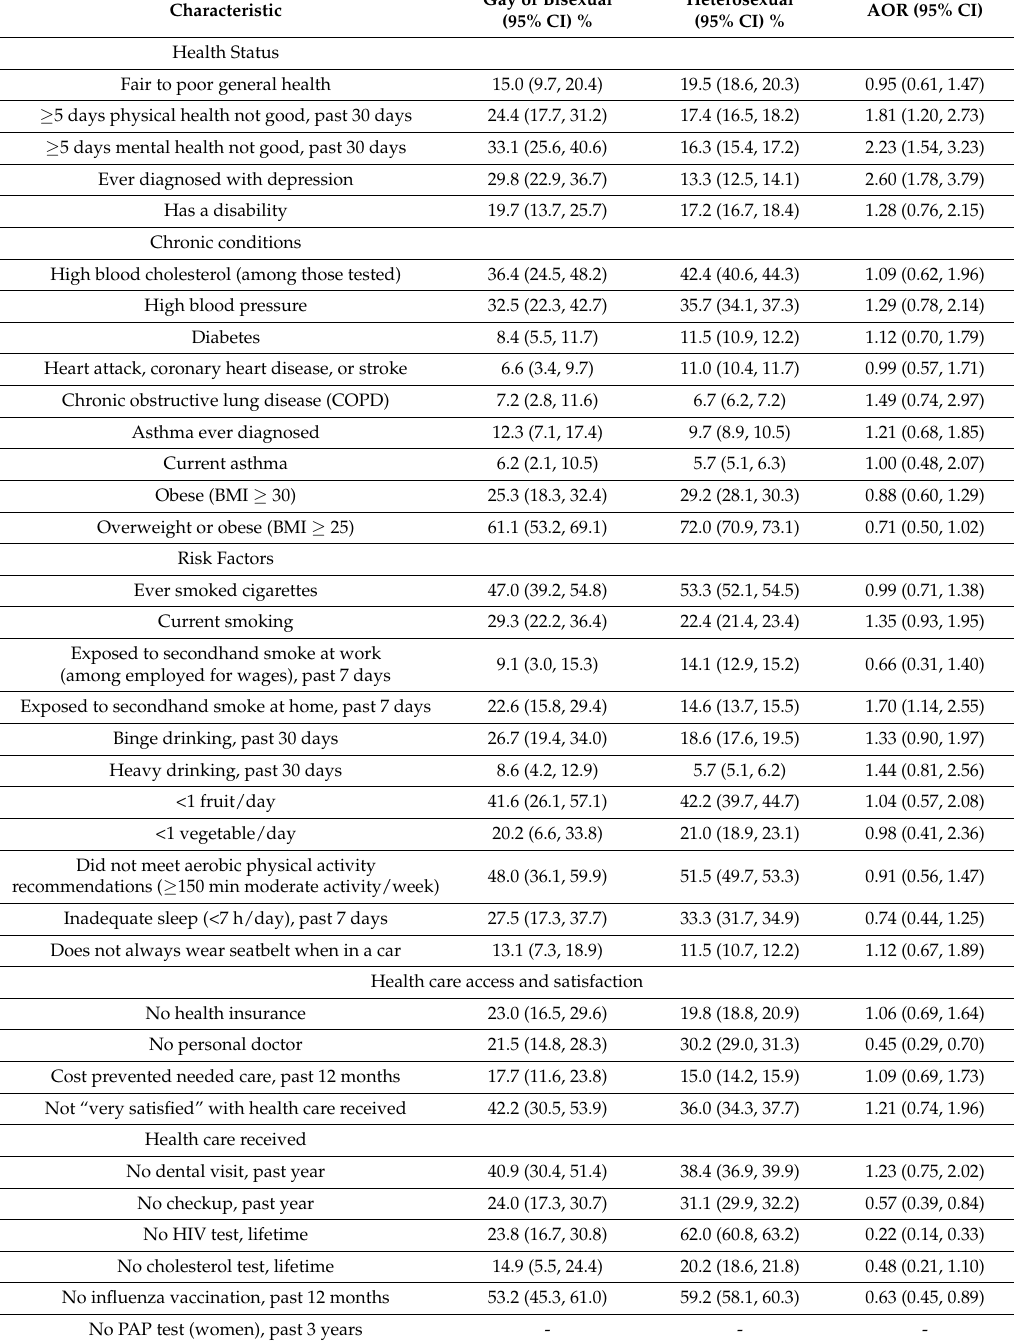
Table 2. Prevalence and 95% confidence intervals (CI) of selected health characteristics among adults by sexual orientation among men, and adjusted odds ratios (AOR), North Carolina Behavioral Risk Factor Surveillance System